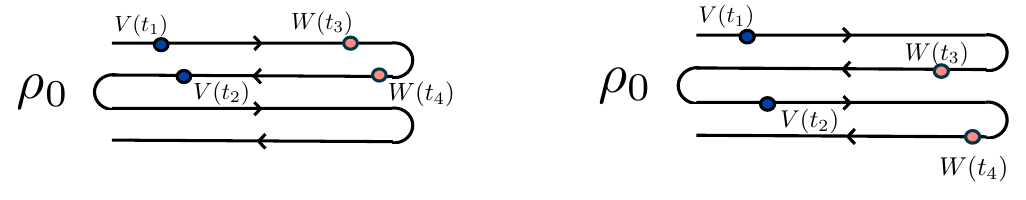
Figure 2 . Left: operator insertions for (2.15). Right: operator inserations for